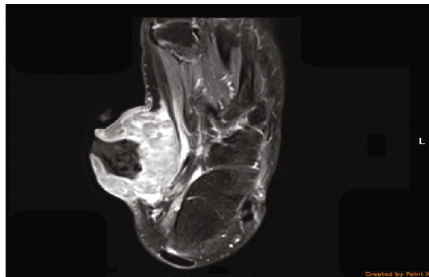
Figure 2: Low-power examination of the tumor with di ff use sheets of round to oval atypical cells separated by thin fi brous septae ( H&E × 100 ).